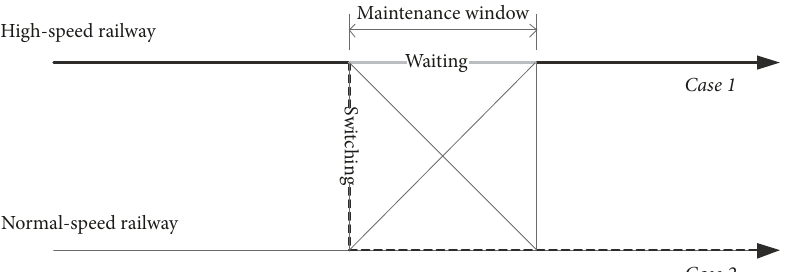
Figure 1: Waiting and switching of SDSA-trains to avoid the conflict with the maintenance window.